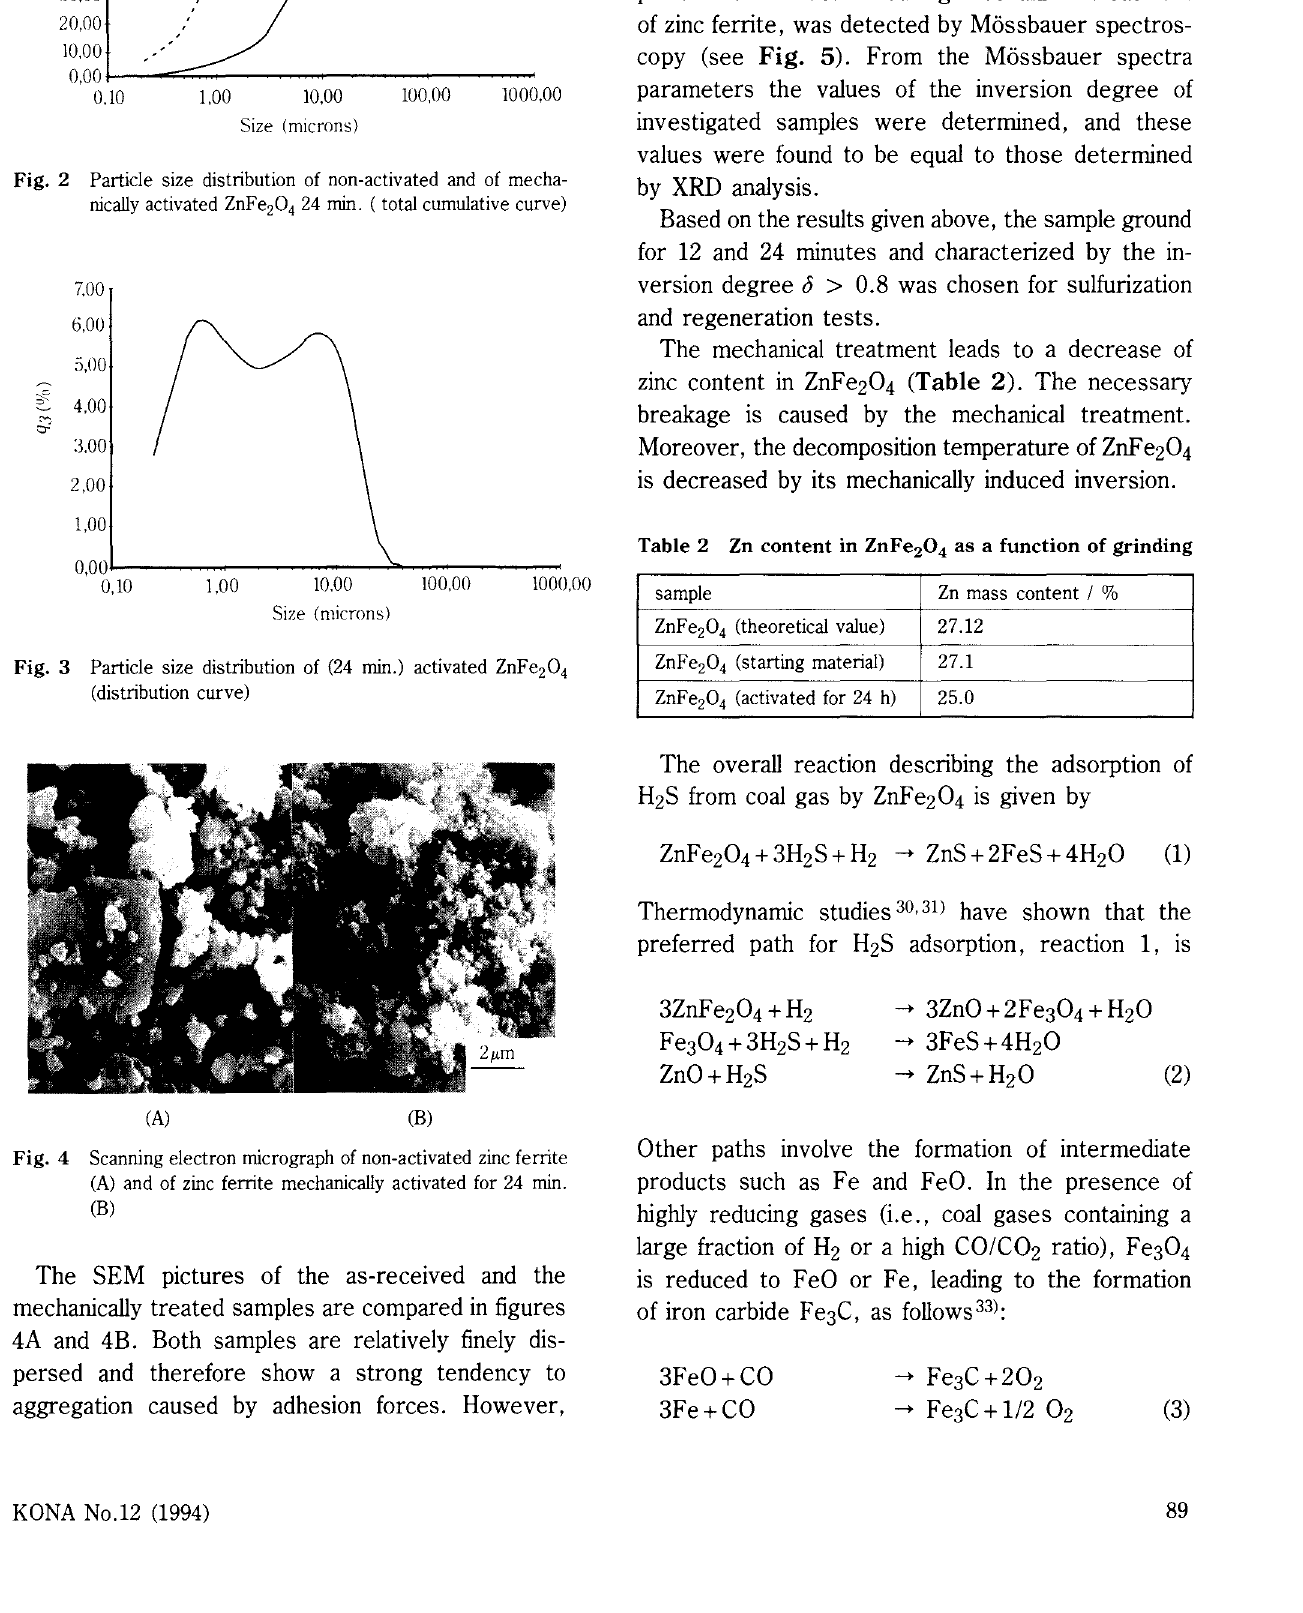
Fig. 2 Particle size distribution of non-activated and of mecha nically activated ZnFe 2 0 4 24 min. ( total cumulative curve)